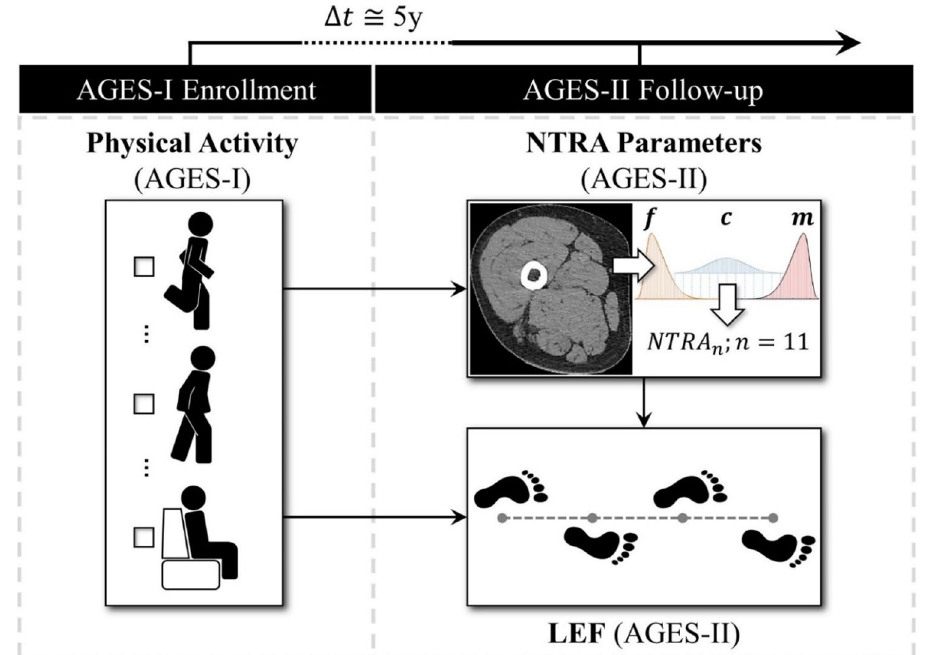
Figure 1. Graphical summary of the present NTRA-based multiple mediation study, showing the theorized role of soft tissue radiodensity changes (NTRA parameters) on the 5-year longitudinal relationship between self- reported physical activity and LEF in elderly AGES-Reykjavík